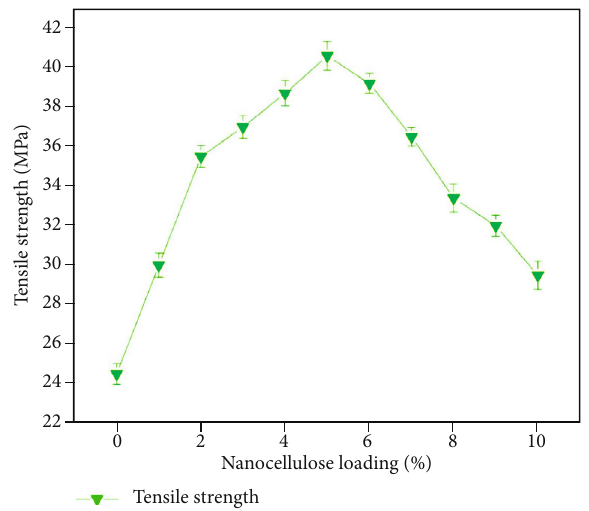
Figure 1: Tensile strength of PVA and PVA-NC composite fi